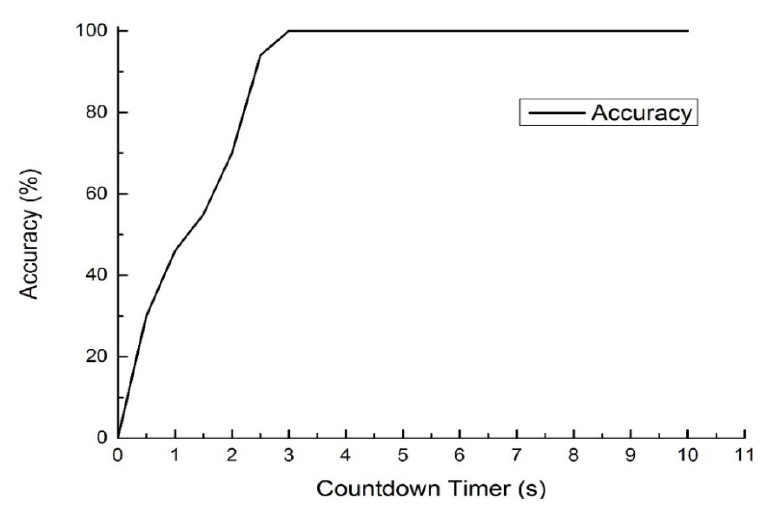
Figure 15. The relationship between the stay duration (countdown timer) and accuracy.